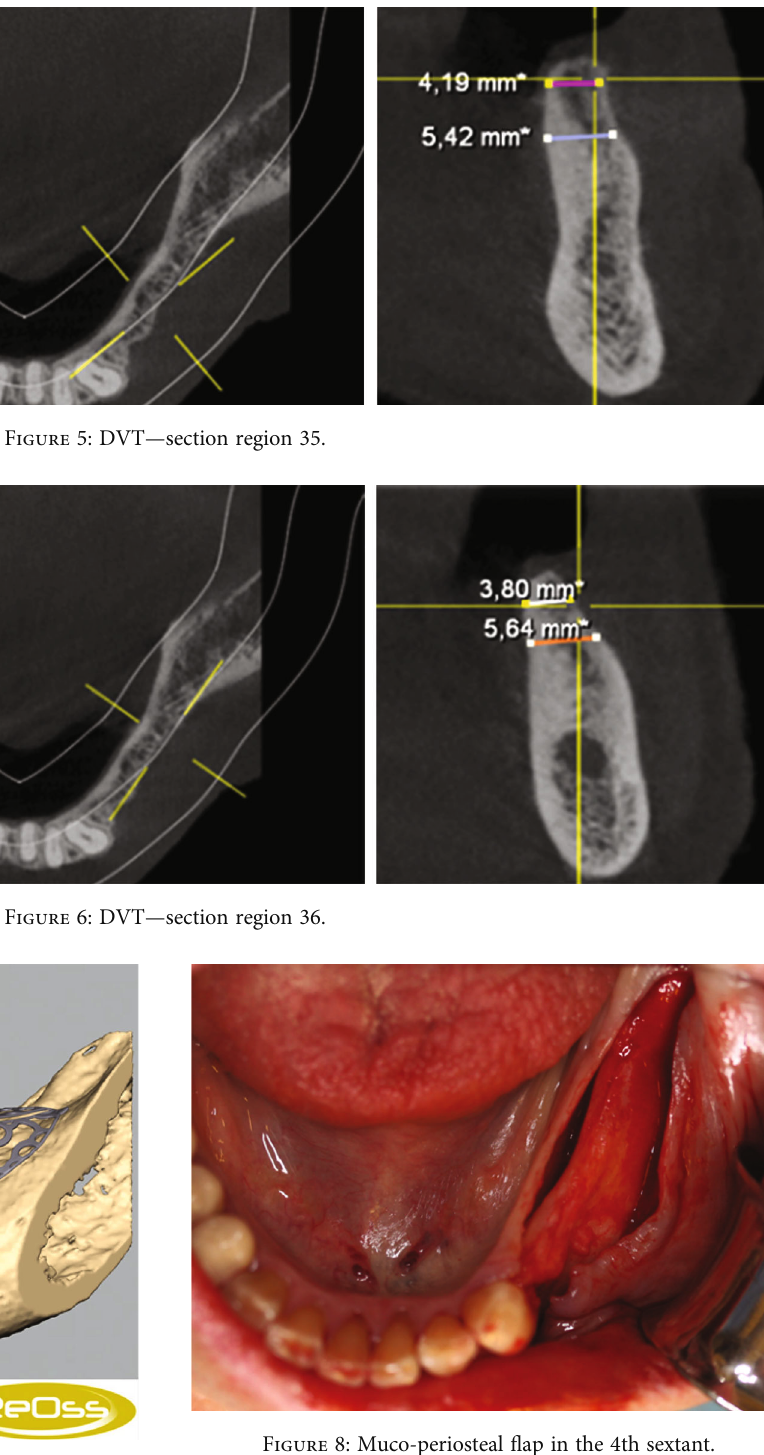
Figure 7: Individualized YxOss CBR® titanium mesh designed and visualized by ReOss®.